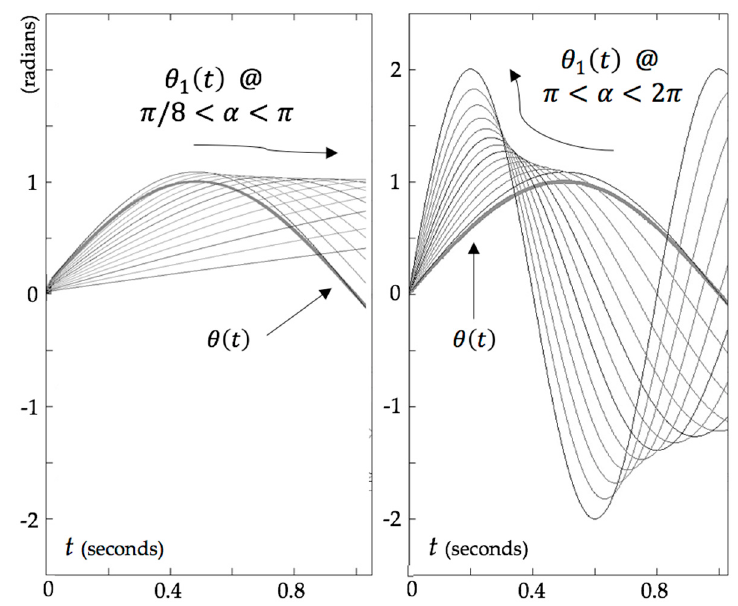
Figure 6. θ 1 transient time response for an excitation of θ ( t ) = θ 0 sin ( α t ) . Low frequency values of α Figure 6. 𝜃 (cid:2869) transient time response for an excitation of 𝜃(𝑡) = 𝜃 (cid:2868) sin(𝛼𝑡) . Low frequency values of to the ( left ), and high frequencies values of α to the ( right ). 𝛼 to the ( left ), and high frequencies values of 𝛼 to the ( right ).